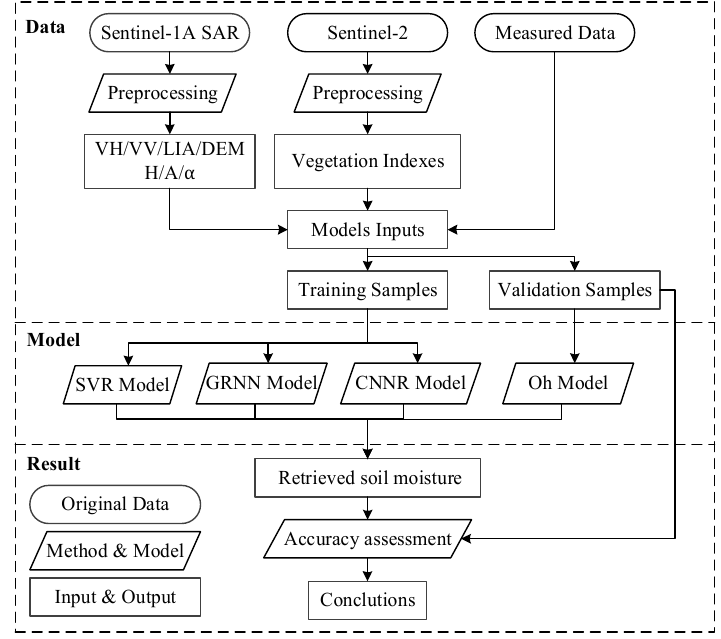
Figure 1. Specific flow chart of the research.